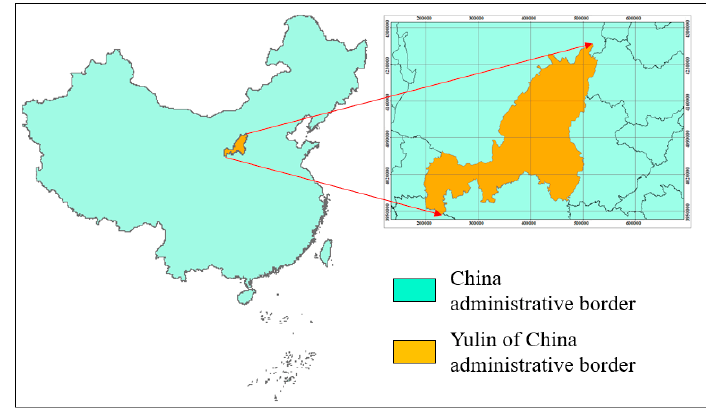
Figure 1. Geographical location of Yulin, Shaanxi Province, China.